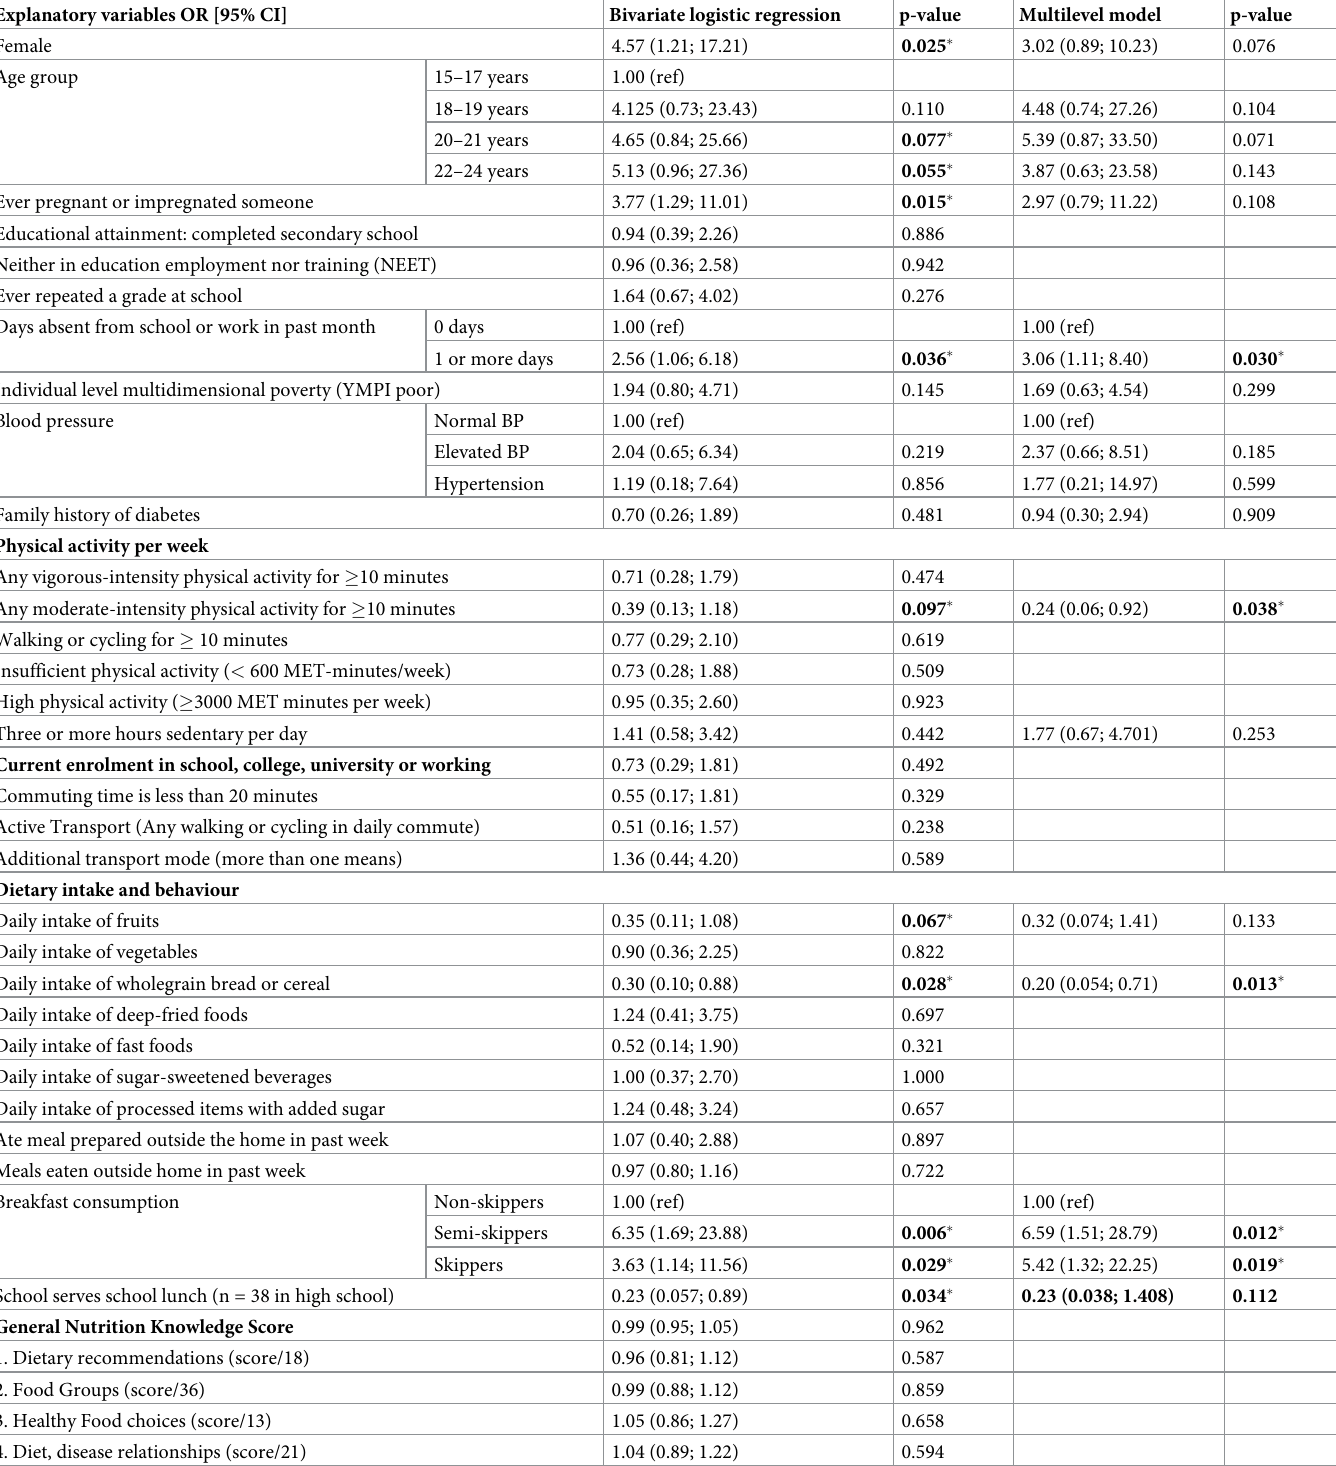
Table 4. Bivariate and multivariate associations between individual-level factors and abdominal